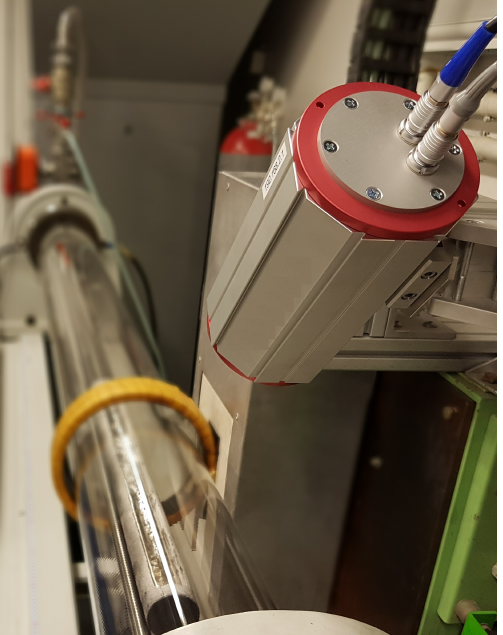
Figure 2. Infrared camera setup focusing on the molten zone region below the induction